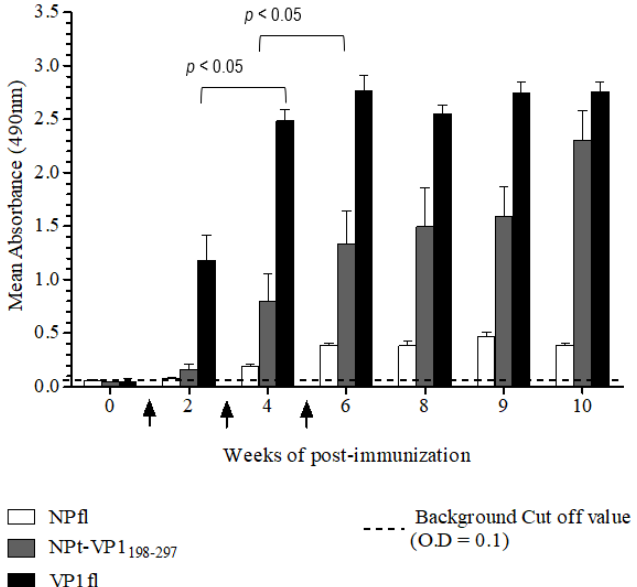
Figure 10. The determination of total IgG titers of anti-VP1 in the immunized sera by ELISA. Immunization time-points were indicated by arrows and the cut-off value was indicated by broken lines. The recombinant NPt-VP1 198–297 (n = 8) proteins elicited a significant IgG level ( p < 0.05).